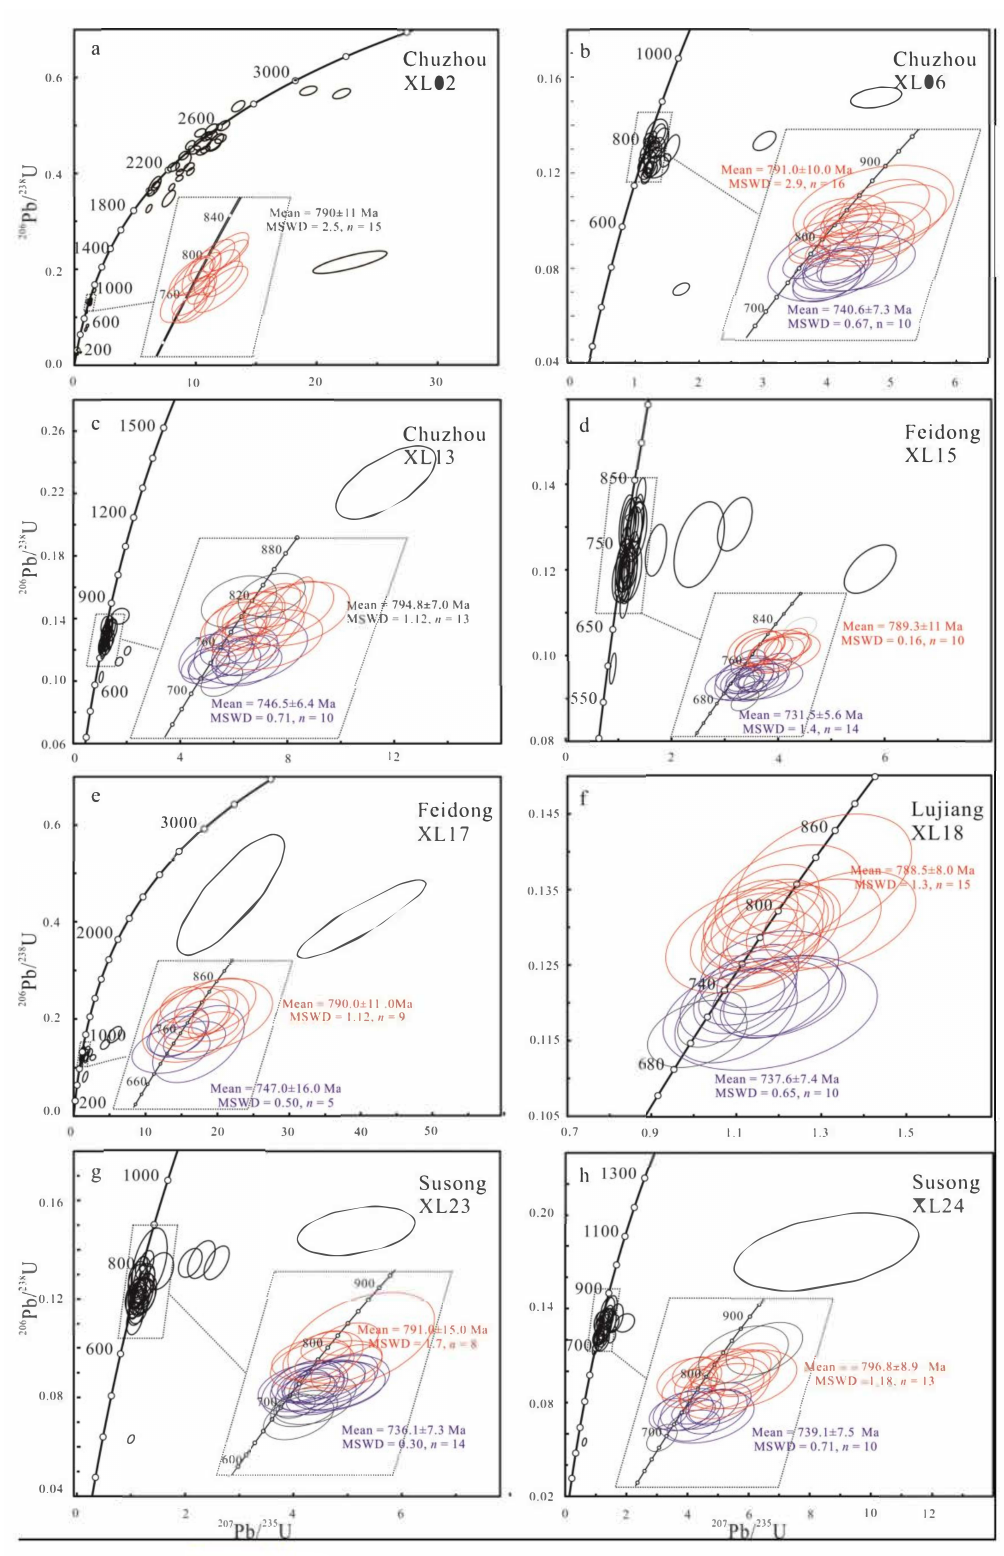
Figure 3. Zircon U-Pb isotopic concordia diagrams for volcanic rocks of the Xileng Formation. ( a ) Early-stage volcanic rocks in Chuzhou; ( b , c ) Late-stage volcanic rocks in Chuzhou; ( d , e ) Late-stage volcanic rocks in Feidong; ( f ) Late-stage volcanic rocks in Lujiang; ( g , h ) Late-stage volcanic rocks in